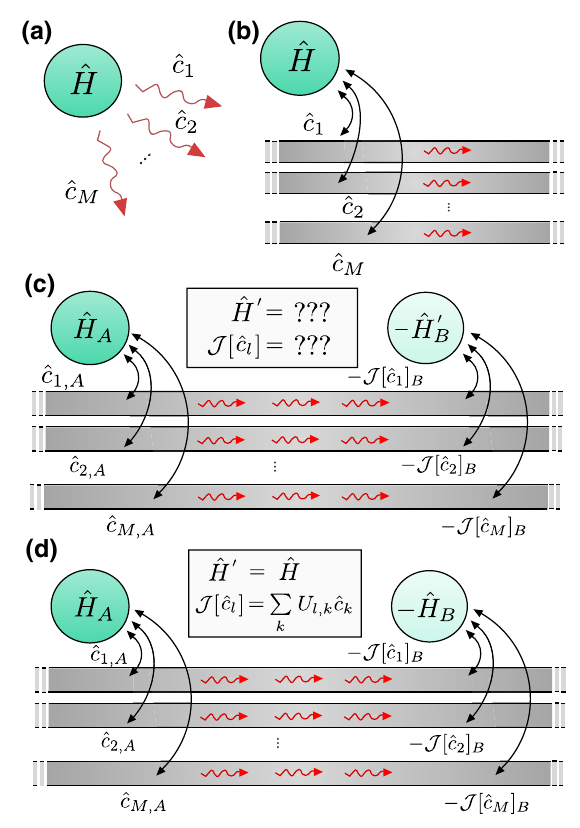
FIG. 4. Hidden TRS and perfect quantum absorbers. (a) A Markovian quantum system evolves according to a master equation in Lindblad form, with Hamiltonian ˆ H and jump oper- ators ˆ c l . (b) A particular realization of the environment as a collection of unidirectional waveguides. (c) The dual Lindbla- ∗ dian L always formally solves the “perfect absorber” problem for the Lindbladian L depicted in (a): when a system described ∗ placed downstream, it absorbs all of the output radiation by L (red squiggly arrows) emitted by the original A systems. As a result, the two quantum systems A and B relax into a pure entan- gled state (which has the general form of a thermofield double state). In general, the Hamiltonian ˆ H (cid:4) and jump operators J [ ˆ c l ] of the B system are extremely complex and difficult to find. (d) If the master equation in (a) has hidden TRS, then it is extremely easy to construct the Hamiltonian and jump operators of the absorber B